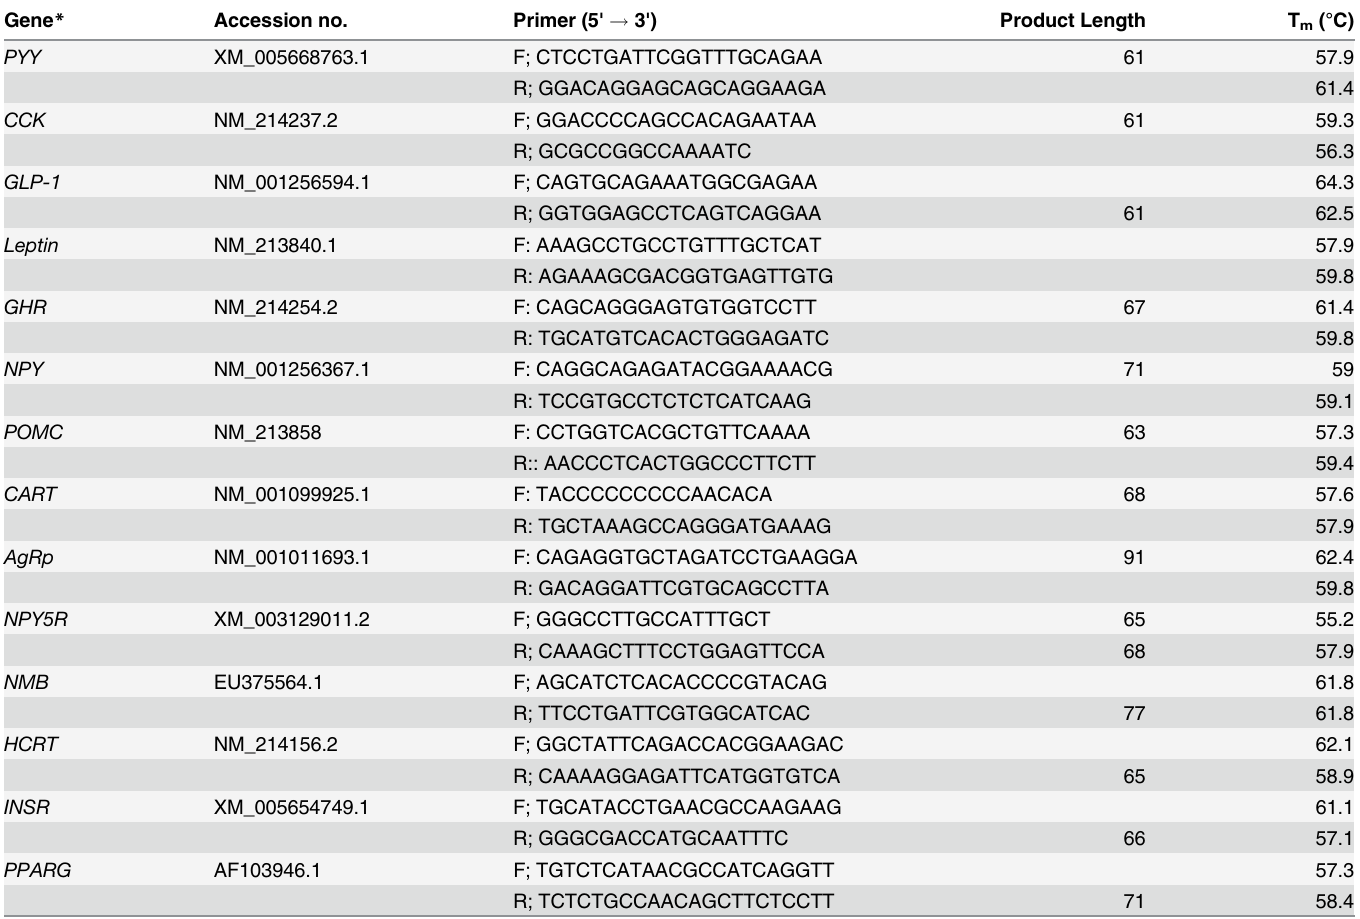
Table 2. Swine-specific primers used for brain, intestinal and adipose tissue real-time PCR. Gene * Accession no.